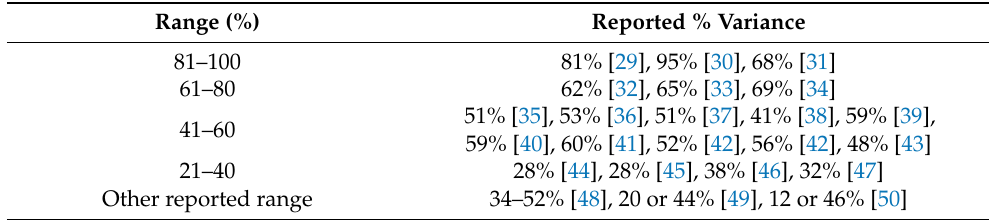
Table 1. Reported explanation of variance in the intention to use a technology solution in the health sector (2000 to 2021,